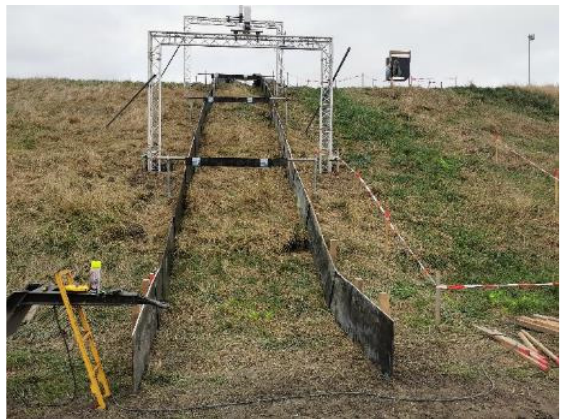
Figure 2. Standard setup of an overflow experiment, view from the landside dike toe. Camera and sensor frames are placed across the 2 m wide test section, prior to execution.